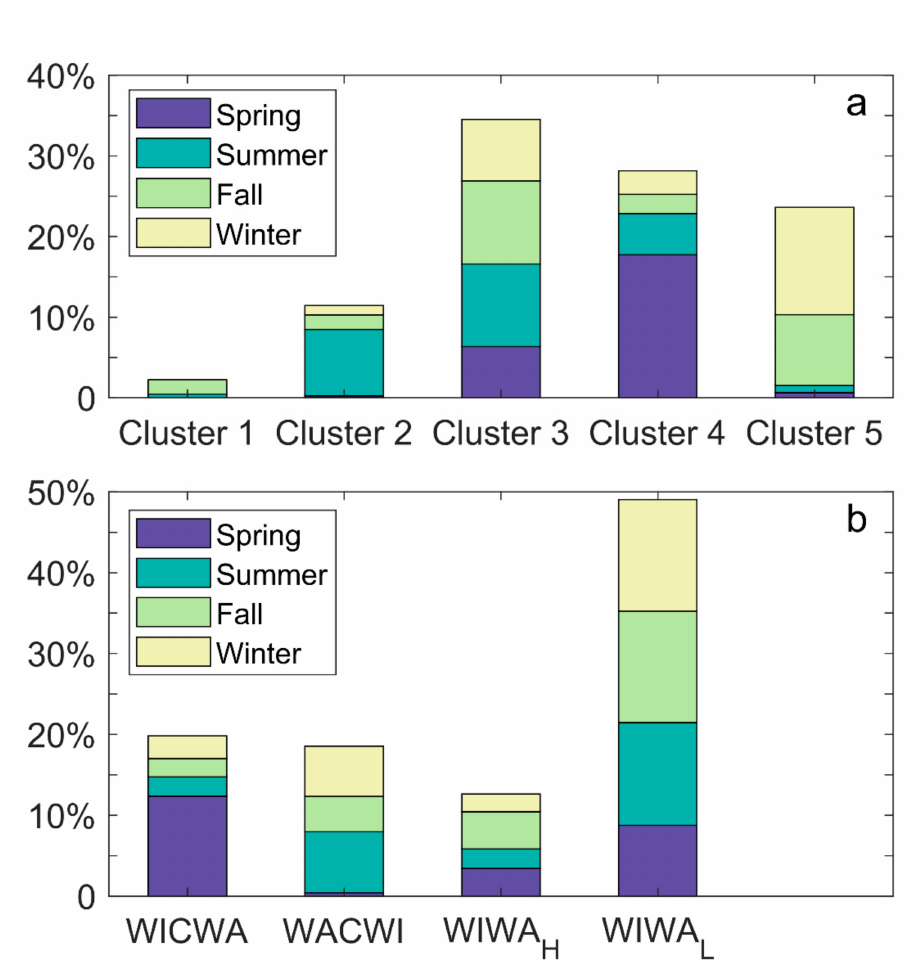
Figure 7. Seasonal frequency distribution according to the meteo-climatic clusters ( a ) and energy patterns ( b ) (September 2020 to August